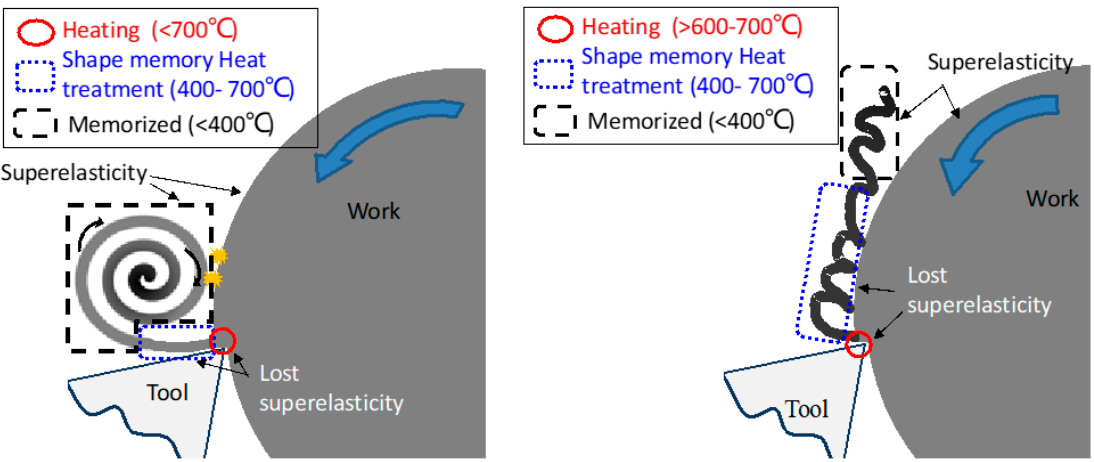
Figure 19. Shape memory mechanism of chip (left: v 25 m / min, right: v 100 m /